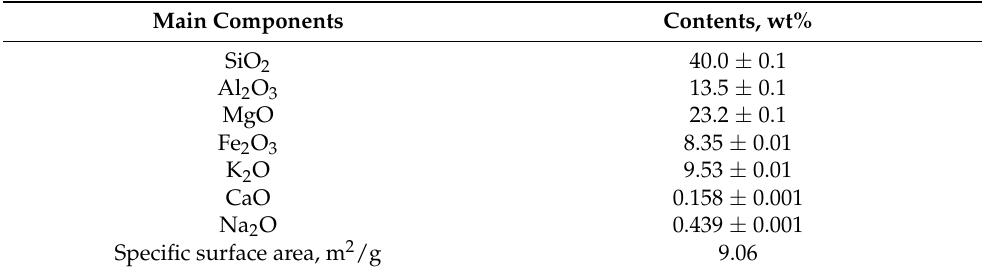
Table 1. Chemical composition of phlogopite.